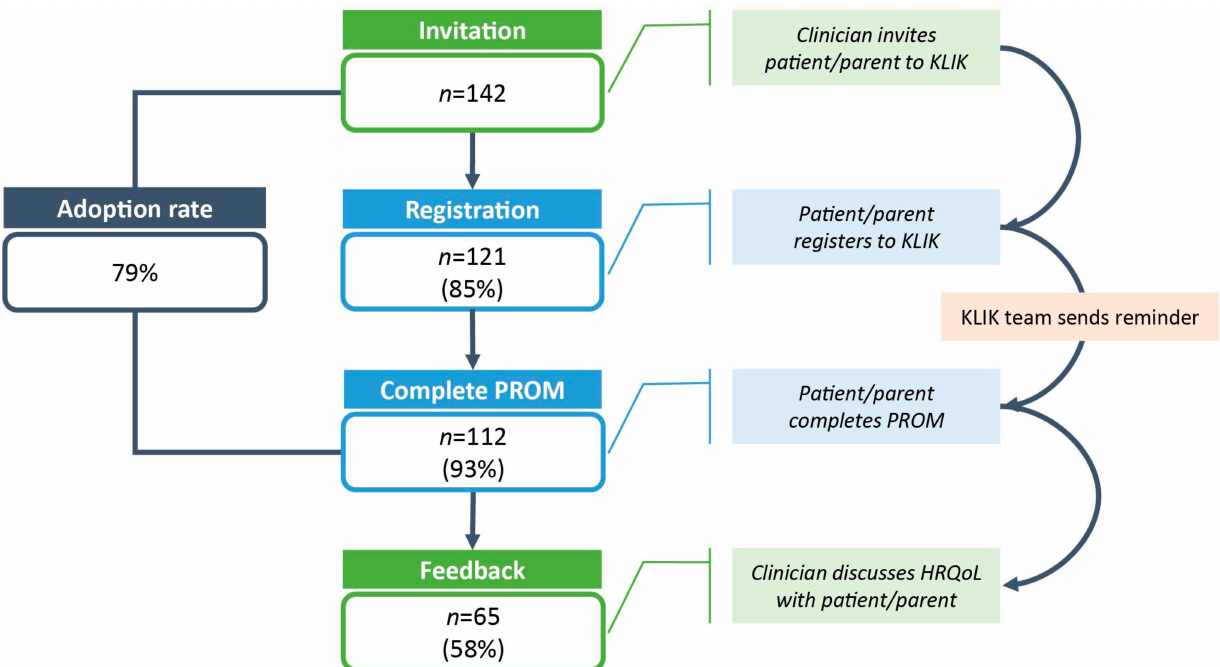
Figure 2. Flowchart of from the implementation of the KLIK PROM portal in the pediatric nephrology department. The adaptation rate is the percentage of patients/parents who were invited to the KLIK PROM portal and completed at least one